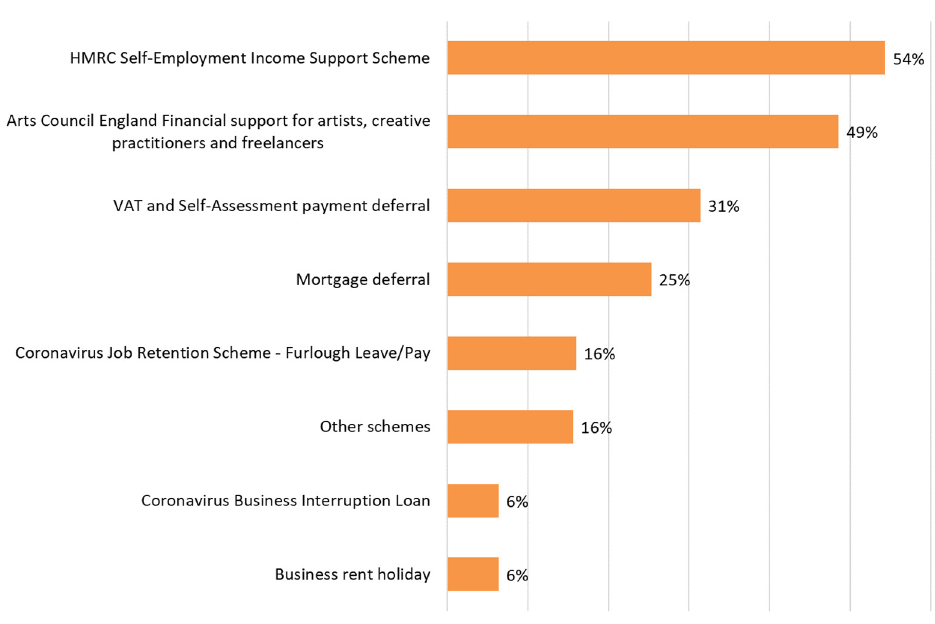
Figure 2. Study 1—awareness of economic support measures in April 2020 (Earthen Lamp).